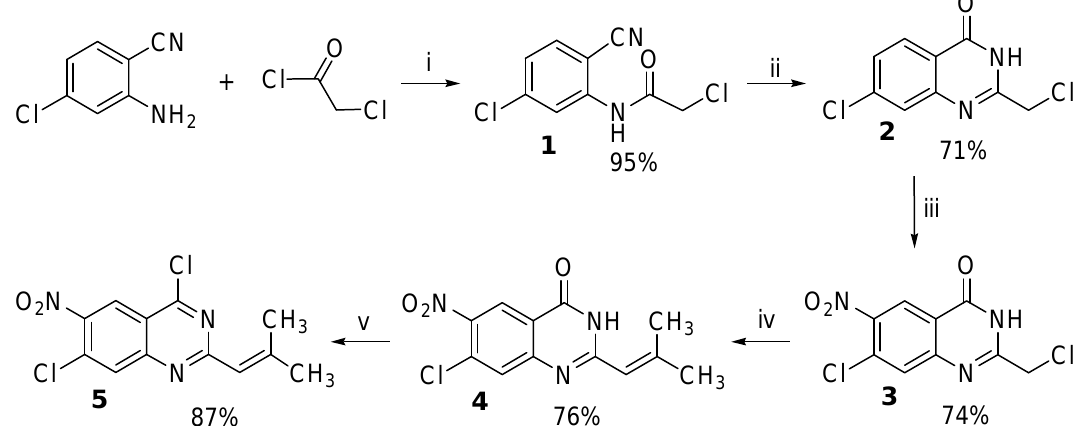
Scheme 1. Synthesis of starting material 5